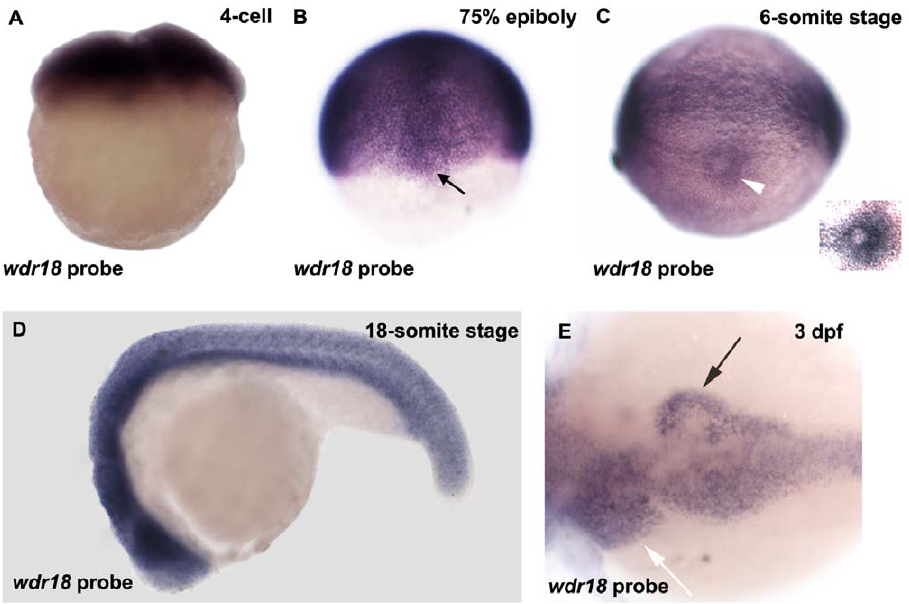
Figure 1. wdr18 expression pattern during early embryonic development in zebrafish. (A) wdr18 is maternally expressed. (B) Expression pattern of wdr18 at the 75%-epiboly stage. Black arrow indicates the staining of dorsal forerunner cells (DFCs). (C) wdr18 expression is detected around the Kupffer’s vesicle (white arrowhead) at the 6-somite stage. Inset is an overexposed magnified image showing elevated wdr18 expression around the KV. (D) wdr18 is detected ubiquitously throughout the whole embryo at 18-somite stage. (E) At 3 dpf, wdr18 is expressed in endodermal organs, including the exocrine pancreas (black arrow), liver (white arrow), and intestine.